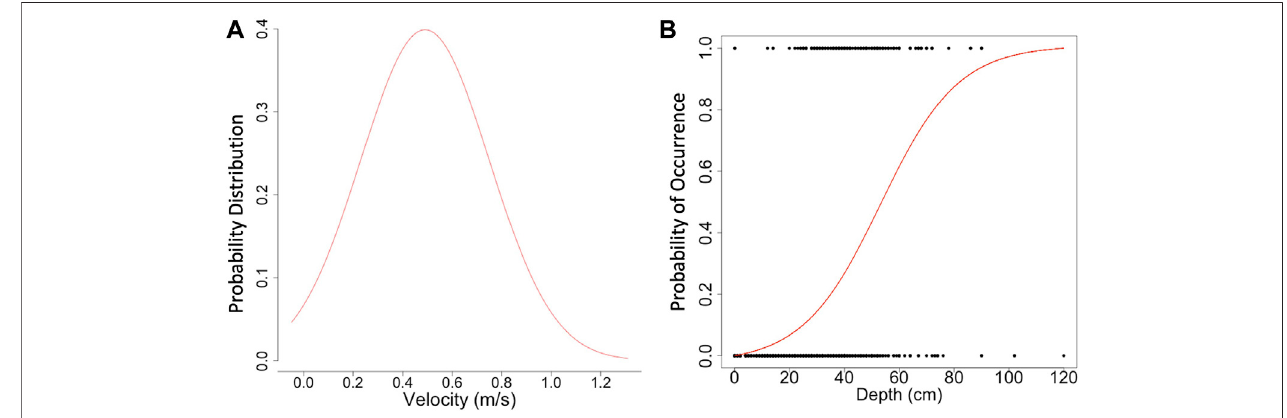
FIGURE6 | Suitabilityrelationships for arroyo chub survival based on velocity (A) and depth (B) . Dataused togeneratecurves were from (Wulffet al., 2017a, Wulff et al., 2017a and 2017b).